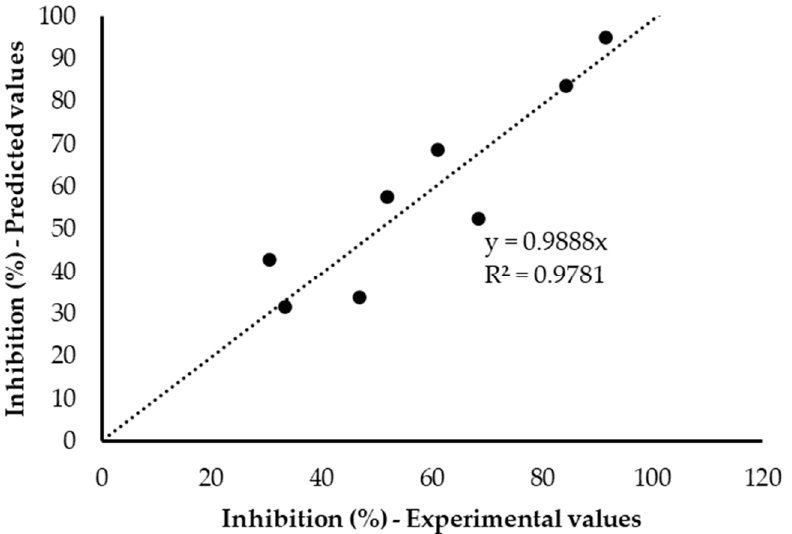
Figure 7. The predicted versus experimental values for the free ammonia inhibitive effect on the PAOs anoxic activity (predicted values were calculated based on Levenspiel’s model).